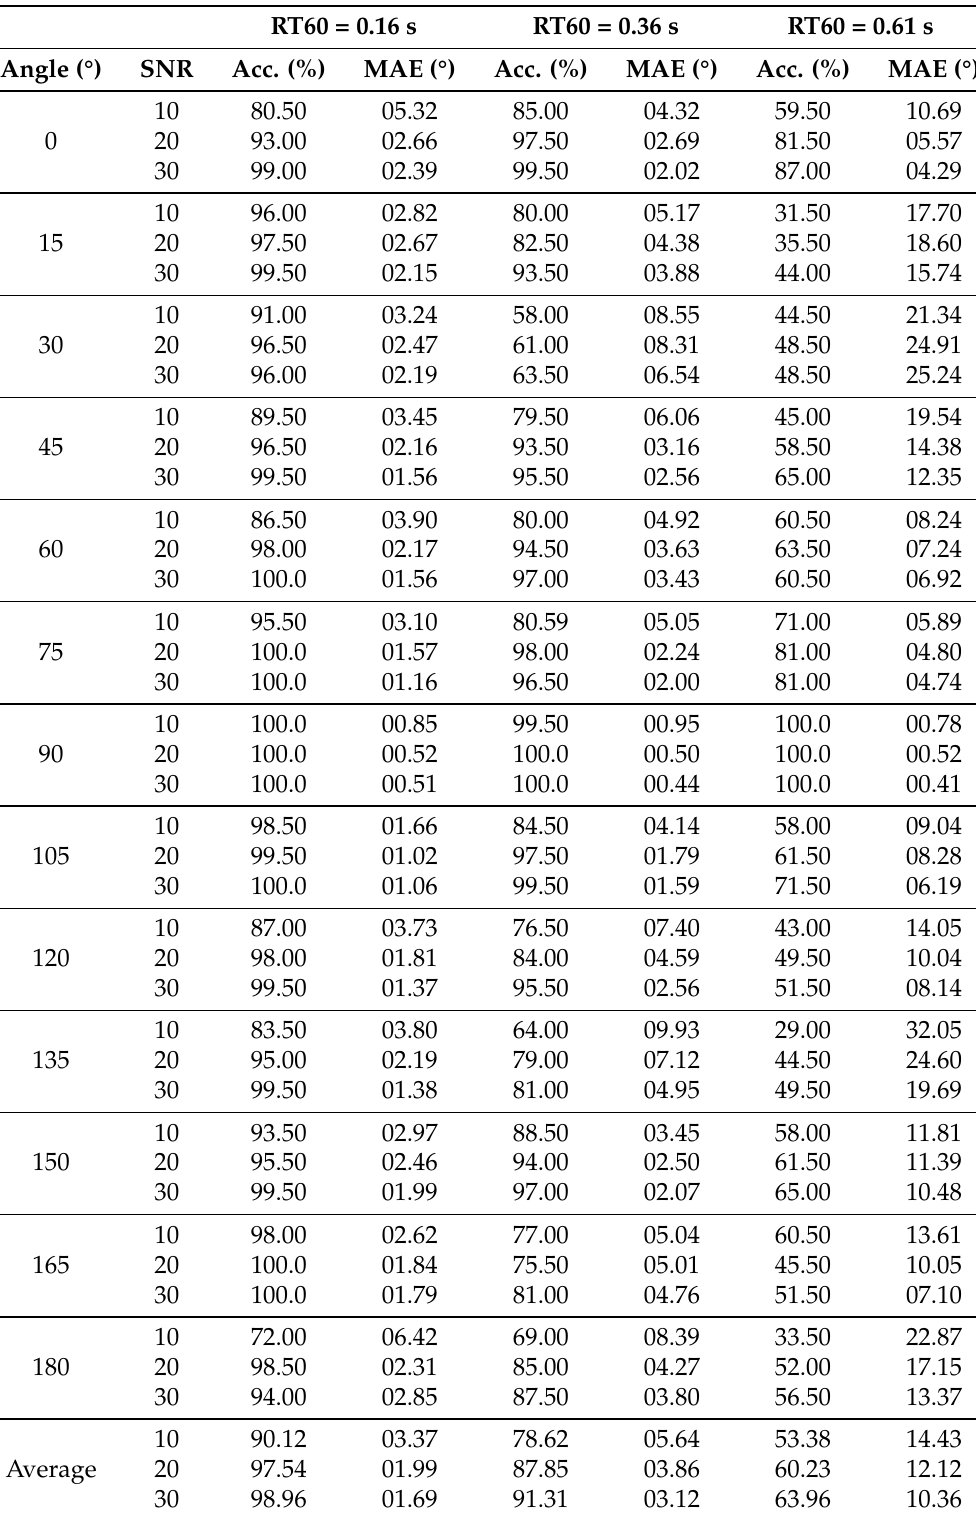
Table 6. Performance of angle estimation by CNN-R in a multiple acoustic environment at SNRs of 10, 20, and 30 dB,